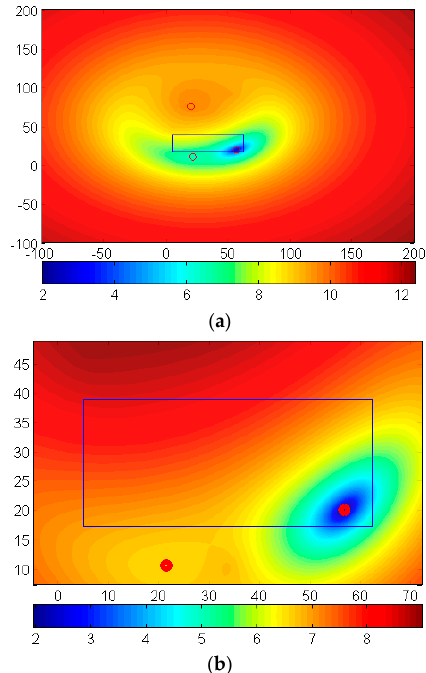
Figure 7. The contour of the logarithm of Equation (1) and the target area (in m): ( a ) contour of 200 m × 200 m square domain, ( b ) contour of 70 m × 45 m square domain.